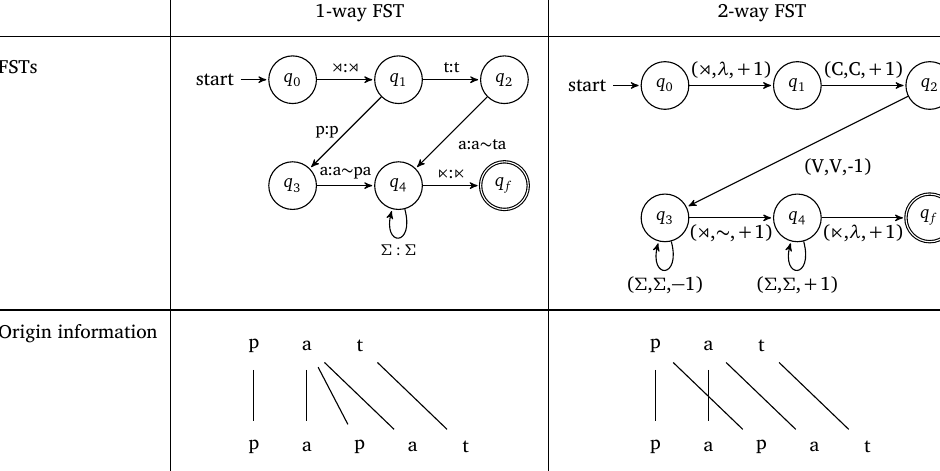
Figure 5: 1-way and 2-way FSTs for initial-CV reduplication and the origin infor- mation created by them for the mapping pat ! pa (cid:24) pat las and Zoll 2005). 11 In contrast, the origin information created by the 1-way FST does not match linguistic intuitions of reduplication because non-identical segments are associated. This difference in the havior: the 1-way FST simply remembers what strings of segments to output twice (Roark and Sproat 2007, 54), while the 2-way FST ac- tively